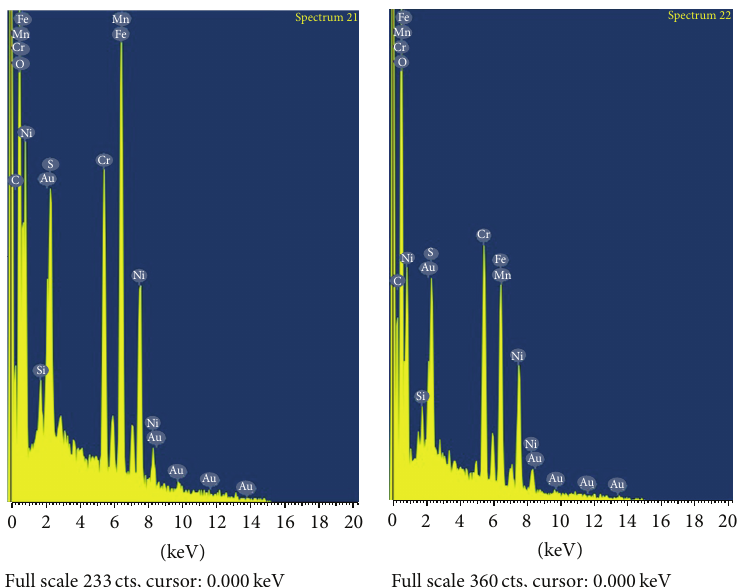
Figure 3: EDS analyses of corrosion products of AISI-309 after five days of exposure in molten salts 50mol% V 2 O 5 -50 mol% Na 2 SO 4 at 700 ∘ C.